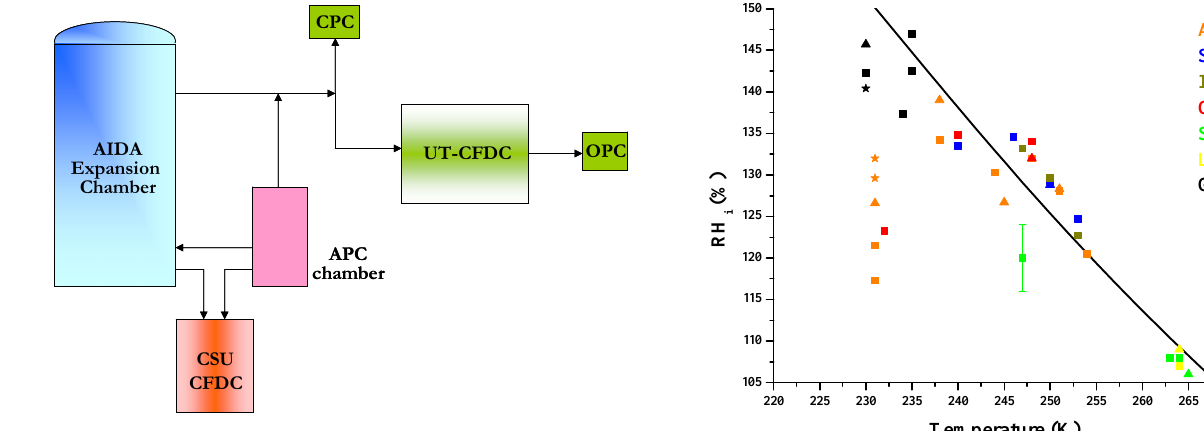
Figure 1 . Schematic of instruments arranged relative to sampling chambers at Fig. 1. Schematic of instruments arranged relative to sampling ICIS 2007 at the AIDA facility at Karslruhe, Germany. The height of the chamber spanned approximately 4 floors. The UT-CFDC was one floor above the CSU- chambers at ICIS 2007 at the AIDA facility at Karlsruhe, Germany. CFDC which was on the ground floor. Arrows indicate the direction of aerosol The height of the chamber spanned approximately 4 floors. The flow. For details of analytic instruments coupled to the AIDA chamber see UT-CFDC was one floor above the CSU-CFDC which was on the Möhler et al [2006] and Möhler et al [2008]. ground floor. Arrows indicate the direction of aerosol flow. For details of analytic instruments coupled to the AIDA chamber see M¨ohler et al. (2006) and M¨ohler et al. (2008).